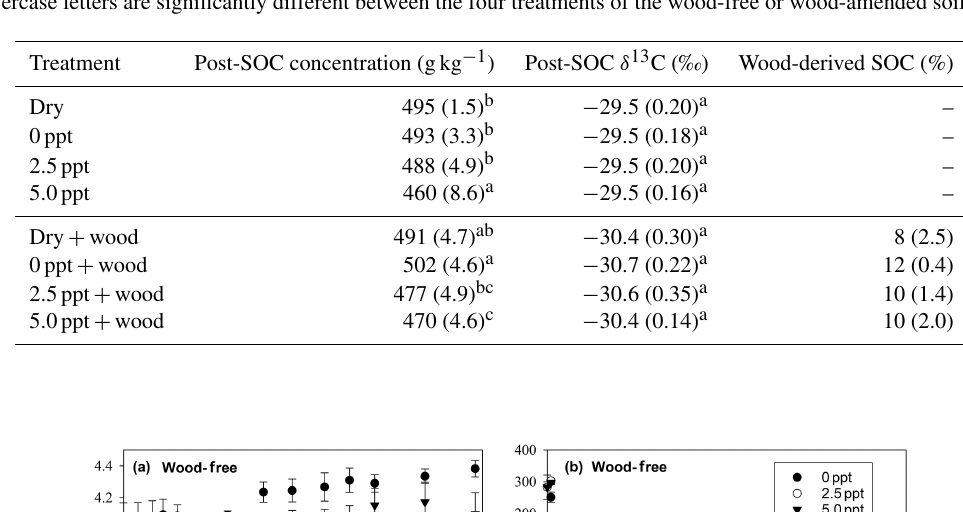
Table 2. Postincubation soil organic C (SOC) concentration (gkg − 1 ), SOC δ 13 C (‰), and wood-derived SOC (%) (estimated from the 13 C two-pool mixing model) for soil samples collected from the field and incubated for 98d in the laboratory under dry conditions (dry) or fully saturated with freshwater (0ppt) or saltwater (2.5 and 5.0ppt) and with ( + wood) or without addition of 13 C-depleted wood. Standard errors of the mean are in parentheses ( n = 4). Data from wood-free and wood-amended soils were analyzed separately. Values followed by different superscript lowercase letters are significantly different between the four treatments of the wood-free or wood-amended soils ( P < 0 . 05).